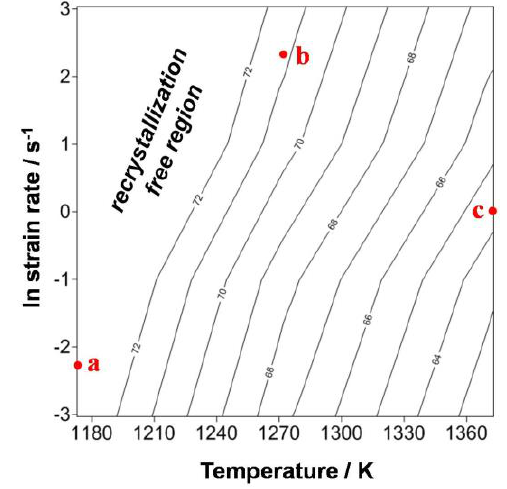
Figure 6. The exponent-type Zener-Hollomon parameter map under different deformation conditions at a true strain of 0.8. The micrographs of the designated points a, b and c are shown in Figure 7.